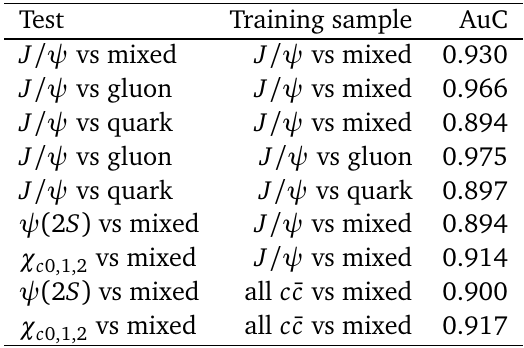
Table 3: Overview of the training results. Mixed background test samples